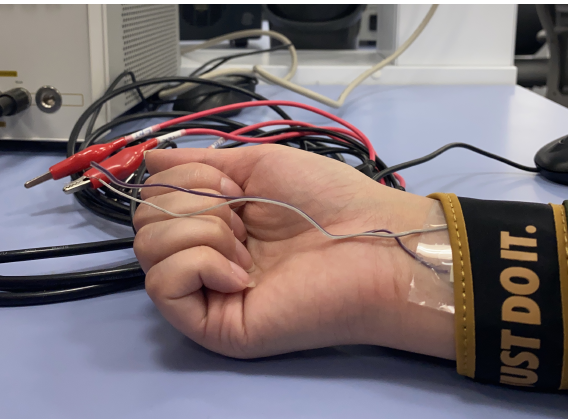
Figure 12. Testing procedure—the electrode strapped on the right wrist of the